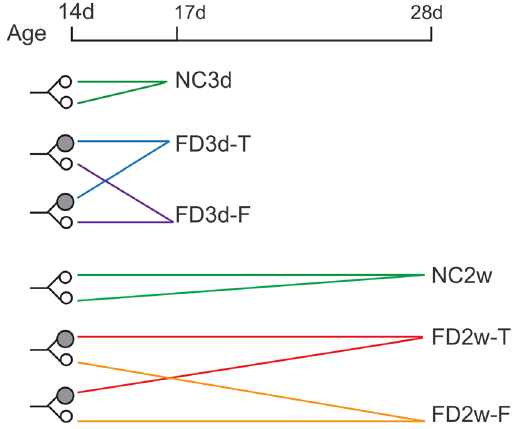
Figure 1. Group assignment paradigm. Guinea pigs were randomly assigned to FD groups and NC groups at an age of 14 days. Animals in the FD groups were monocularly deprived, whereas those in the NC groups did not receive any treatment. A filled circle indicates an FD eye, and an open circle indicates an unpatched F eye. Twenty-four animals in the FD and 10 in NC groups were sacrificed 3 days later (i.e., 17 days of age), and the eyes were designated as FD3d and NC3d, respectively. Two FD eyes from 2 animals in the FD3d group were pooled together and designated as FD3d-T, and the two F eyes were pooled and named FD3d-F. Twenty-four animals in the FD and 12 in NC group were sacrificed at the age of 28 days and designated as NC2w and FD2w. Two FD eyes from 2 animals in the FD2w group were pooled together and designated as FD2w-T, and the two F eyes were pooled and designated as